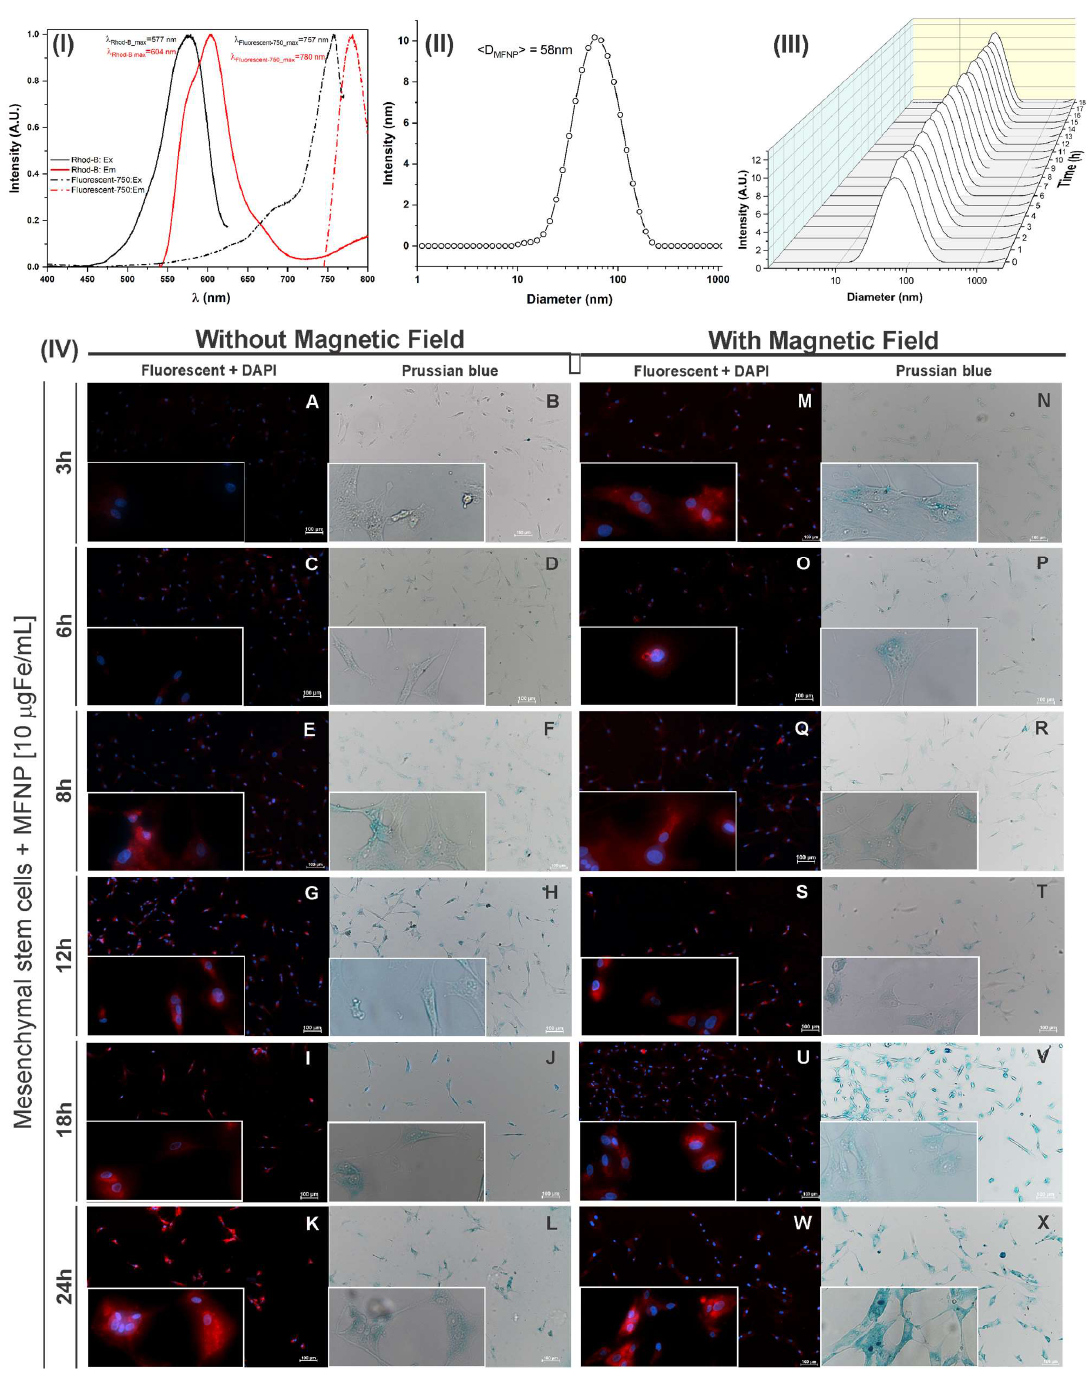
Figure 2. Multifunctional nanoparticle characterization by optical properties ( I ), hydrodynamic size ( II ), and stability ( III ). Microscopy optical images of hBM-MSC labeled with 10 µgFe/mL of MFNP ( IV ) by fluorescence, highlighting in blue (DAPI), the cell’s nucleus containing the iron of MFNP and the red the MFNP internalized into MSC without magnetic field ( A , C , E , G , I , K ) and with a magnetic field ( M , O , Q , S , U , W ), and by brightfield without magnetic field ( B , D ,F, H , J , L ) and with a magnetic field ( N , P , R , T , V , X ) at different times of incubation. Abbreviations: MFNP—Multifunctional nanoparticle.